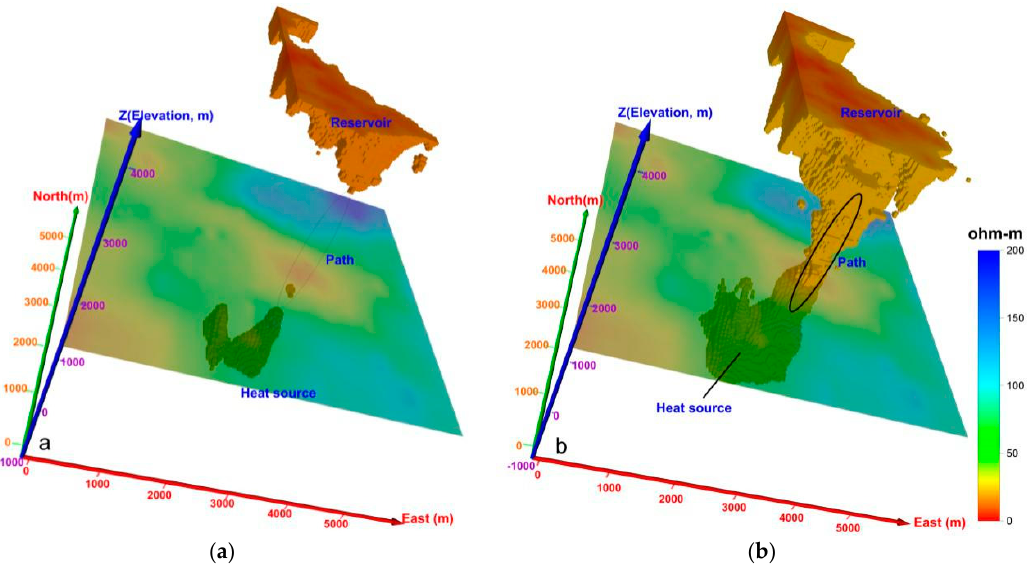
Figure 6. 3D resistivity imaging shows the resistivity volume with a value lower than ( a ) 15 and ( b ) 22 Ω∙ m for the eastern portion of the QP geothermal field. A low ‐ reisitivity volume with a value lower than 15 Ω∙ m ( a ) reflects the heat source and upper portion of geothermal reservoir, another data volume of lower than 22 Ω∙ m reflects the whole geothermal system, including the heat source, path, and the reservoir. The path has a higher resistivity of 15–22 Ω∙ m than the heat source and the reservoir.